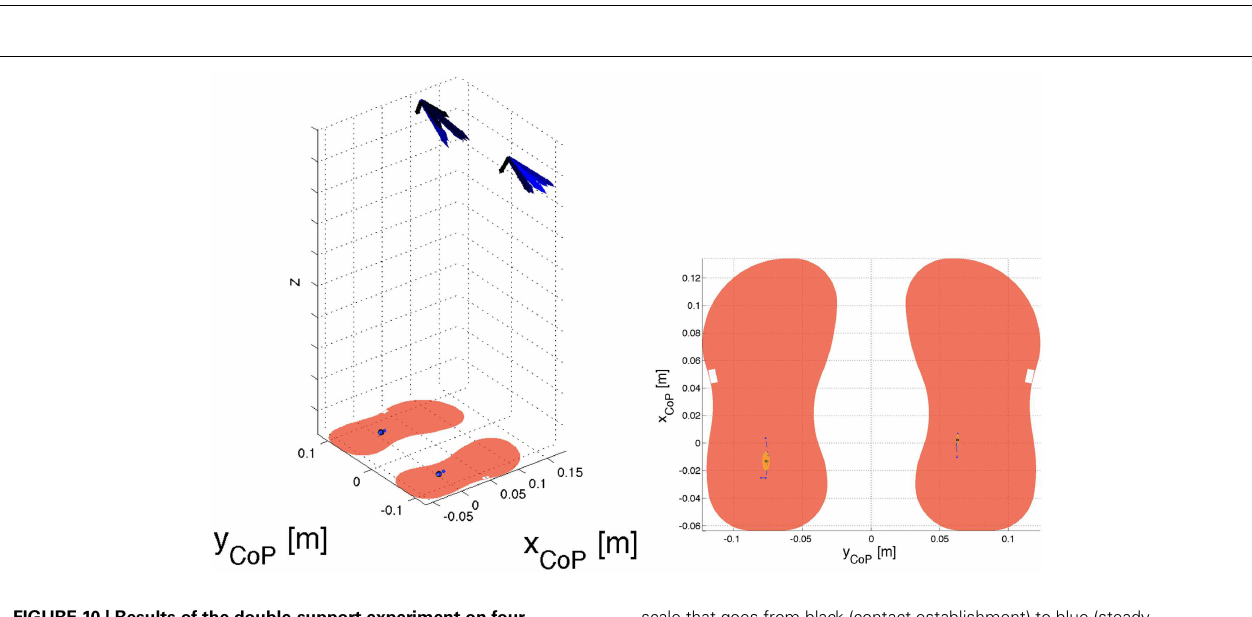
FIGURE 10 | Results of the double-support experiment on four non-coplanar contacts (both feet and arms) .The left picture gives a three-dimensional view of the foot center-of-pressure positions together with the arm contact forces. Forces are represented in a color